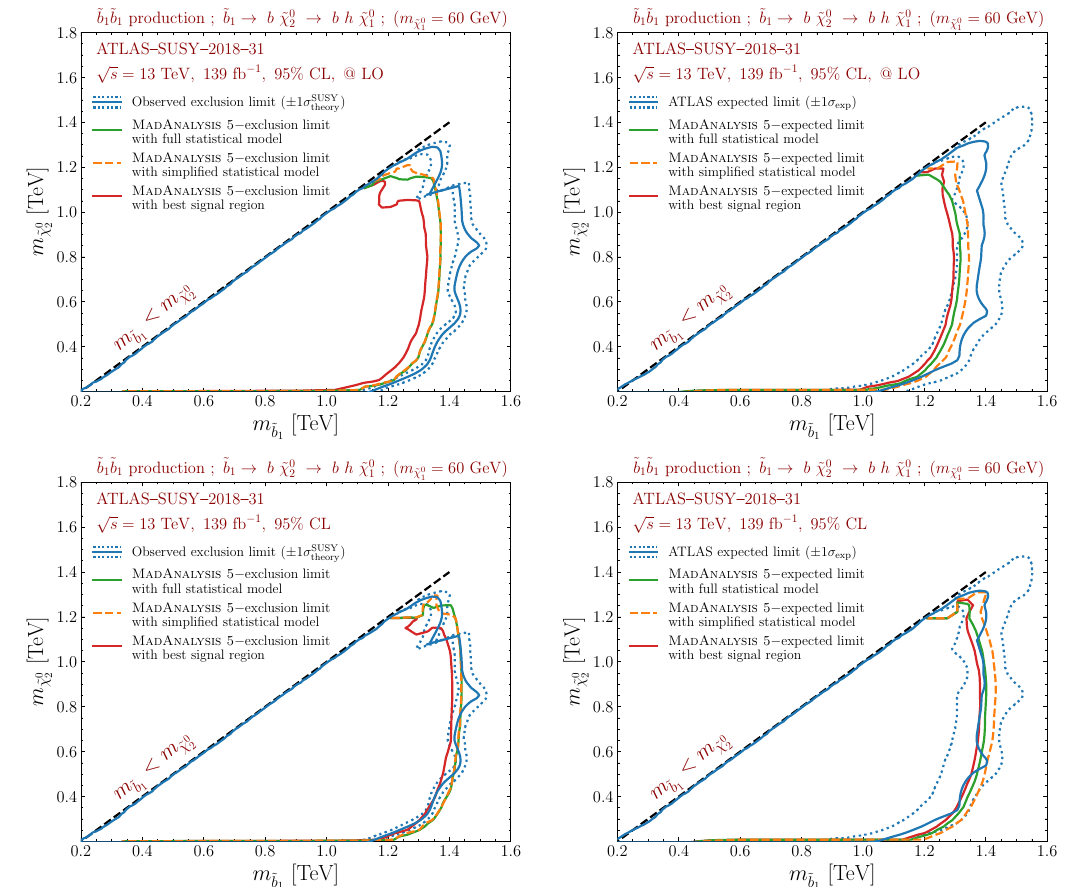
→ bh ˜ χ 0 simpli- 2 1